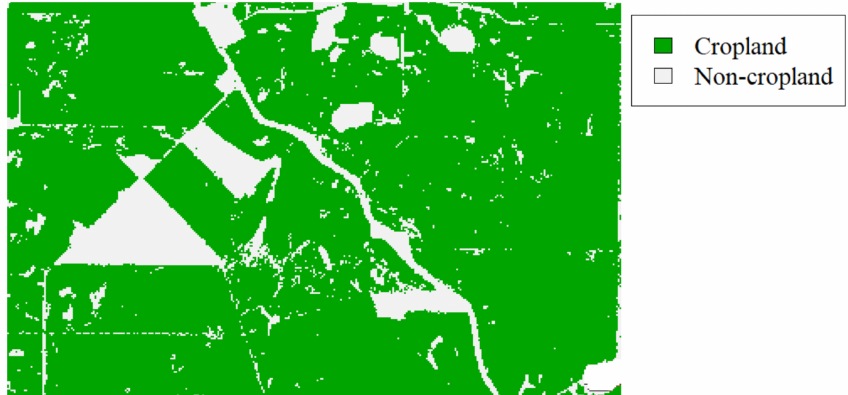
Figure 5. Cropland mask used for accuracy assessment.